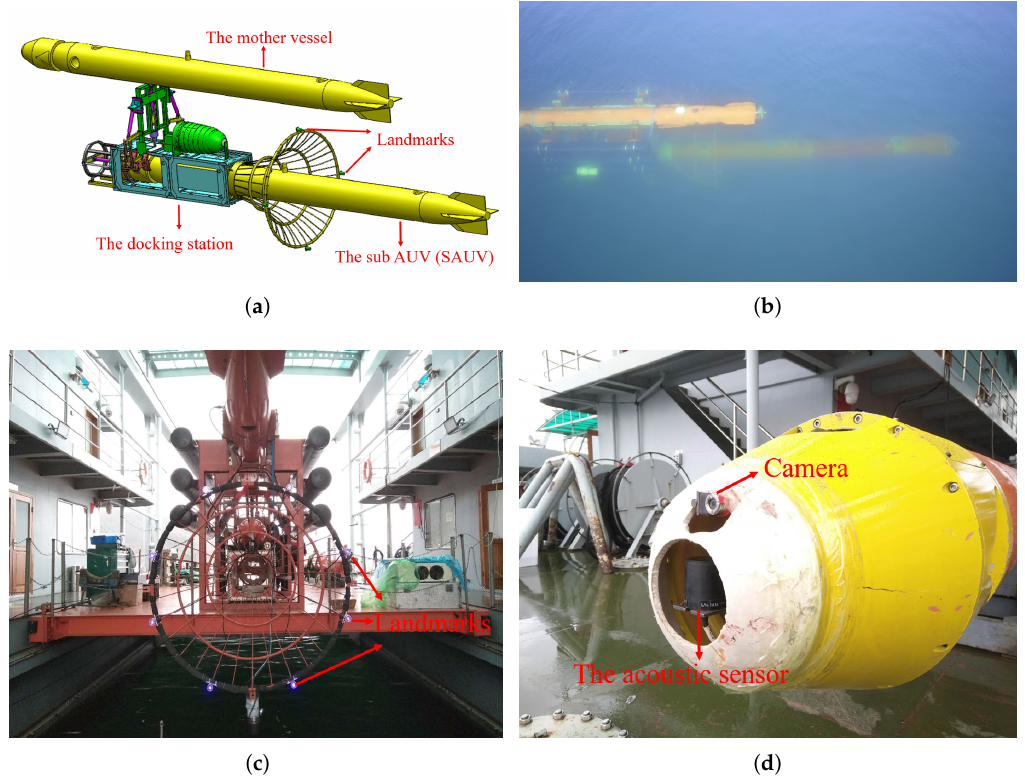
Figure 1. Autonomous underwater vehicle (AUV) recovery illustrated by ( a ) the simulation model and ( b ) field experiments, captured by an unmanned aerial vehicle. ( c ) Landmarks mounted on the docking-station rim. ( d ) Camera and acoustic sensor on the AUV